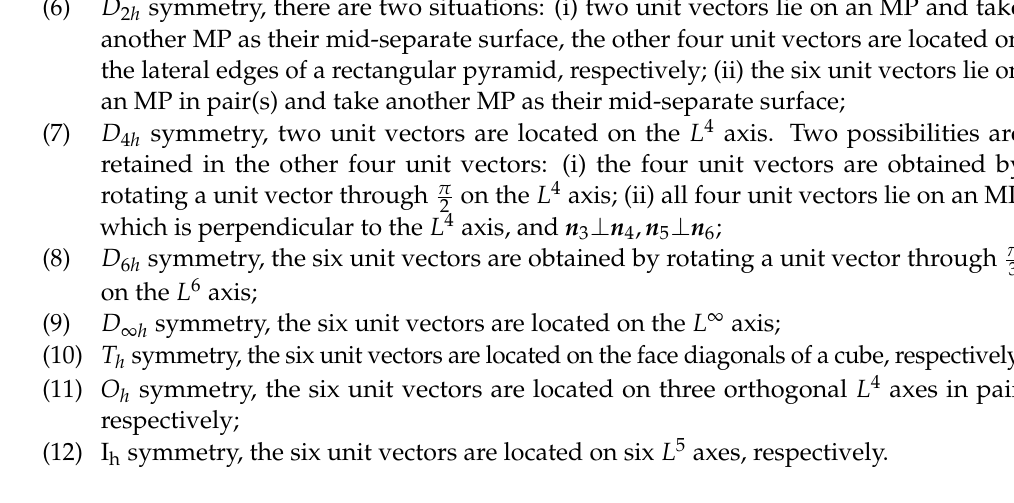
Table 6. Symmetry types and the unit vector sets of H (6)